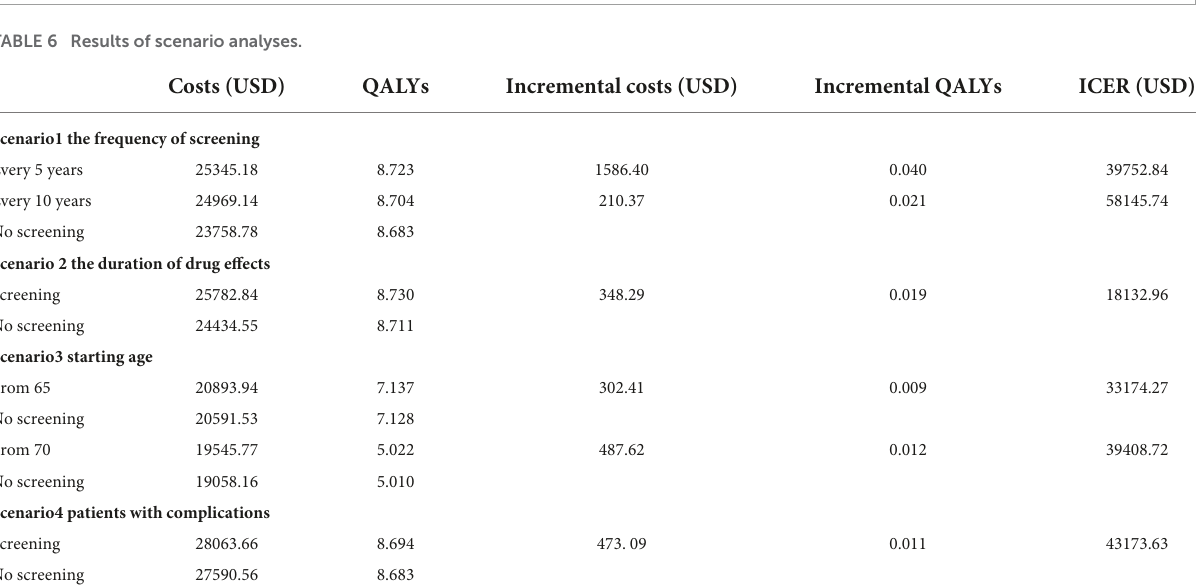
FIGURE4 Cost-effectiveness acceptability curve.